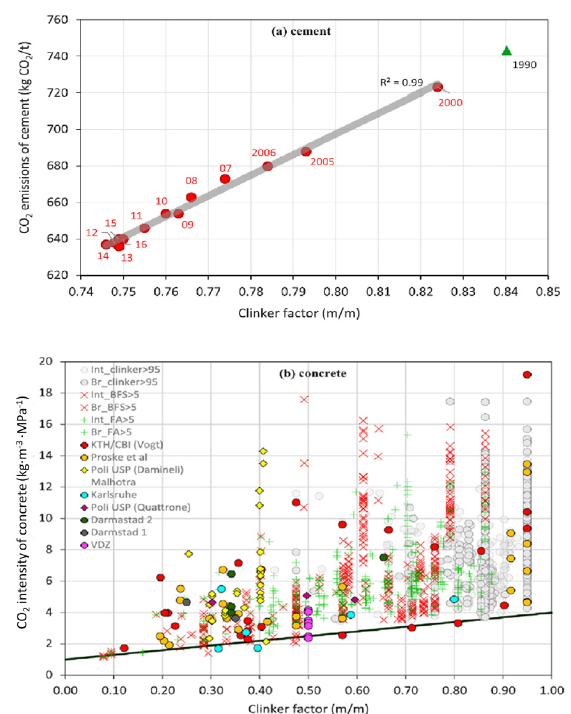
Figure 7. Correlation of CO 2 emission/intensity with clinker factor in a) cement and b) concrete, reproduced with permission from [61]. CO 2 emissions and the clinker factor are linearly correlated whereas this is not the case for concrete due to the large variety of possible mix designs. The black line in Figure (b) represents what could be technically achieved without considering rheological properties. Readers are referred to the original publication for more